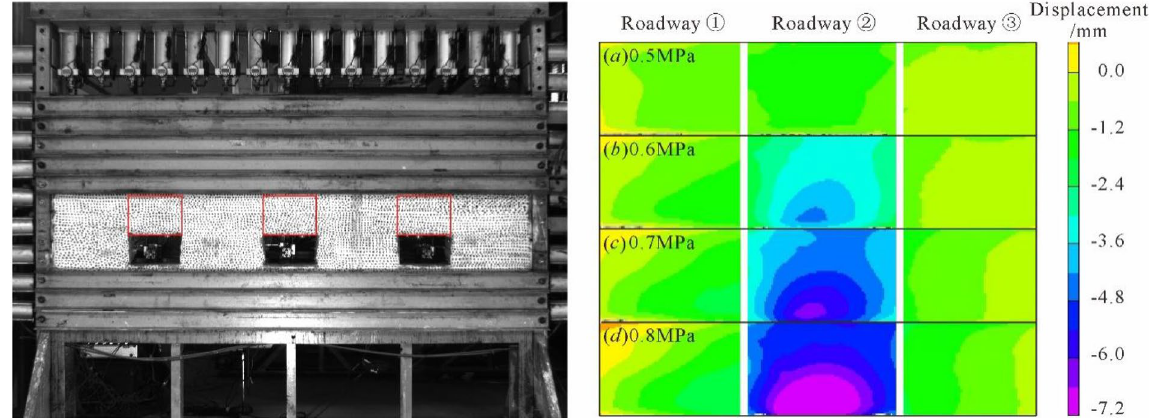
Figure 17. Evolution characteristics of displacement field of surrounding rock of each roadway under progressive loading.